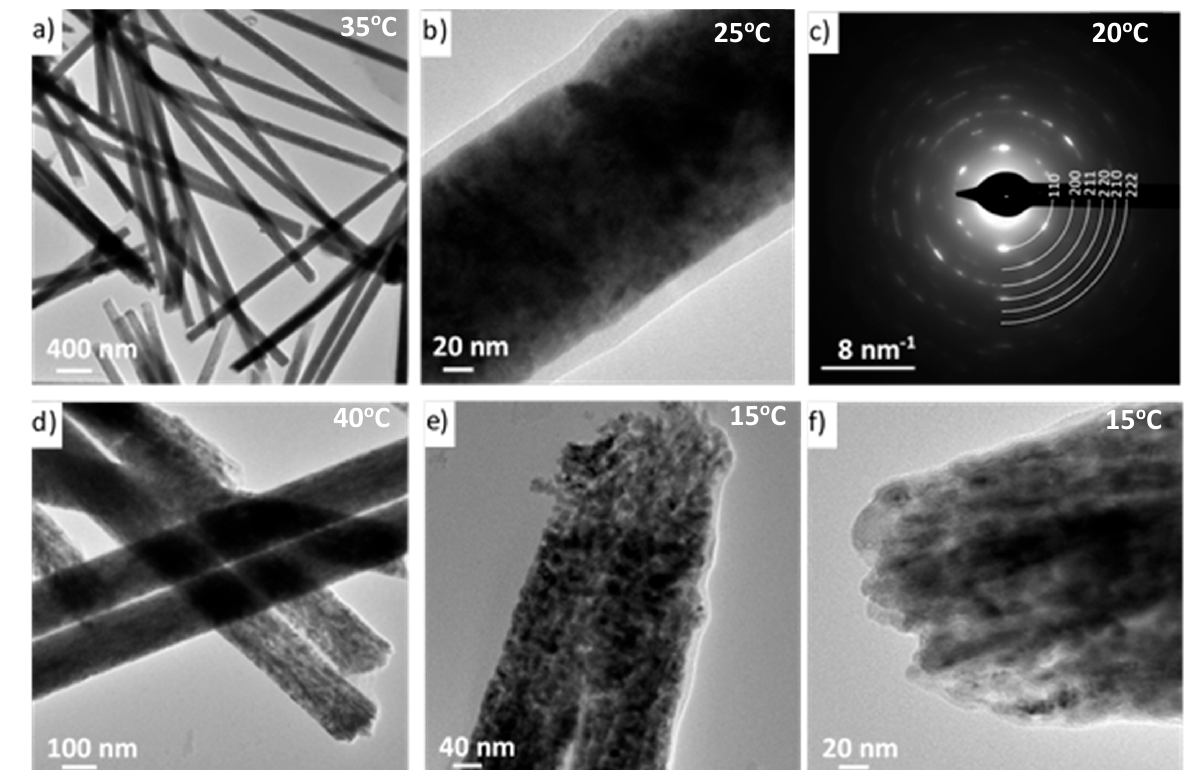
Figure 8. TEM images of Fe nanowires in bright-field mode with diffraction pattern ( a ) 35 °C, ( b ) 25 °C, ( c ) 20 °C, ( d ) 40 °C, ( e , f ) 15 °C indexed with the lattice parameters of bcc Fe structure.